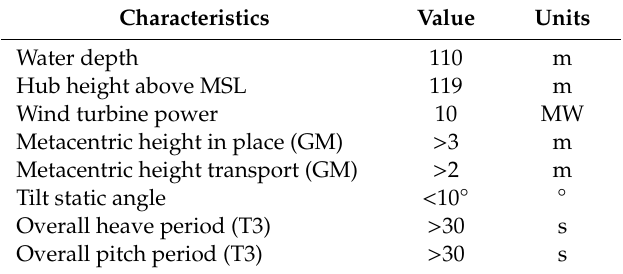
Table 2. Characteristics of the Telewind ® platform. Source: Data courtesy of